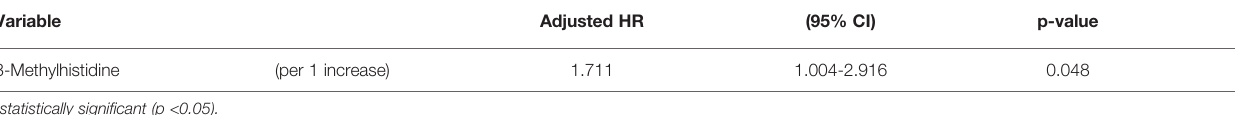
*statistically signi fi cant (p <0.05). HR, hazard ratio; CI, con fi dence interval. Adjusted for variables with p <0.05 in the multivariate analysis in the training group: 3-Methylhistidine and 5-Hydroxylysine.